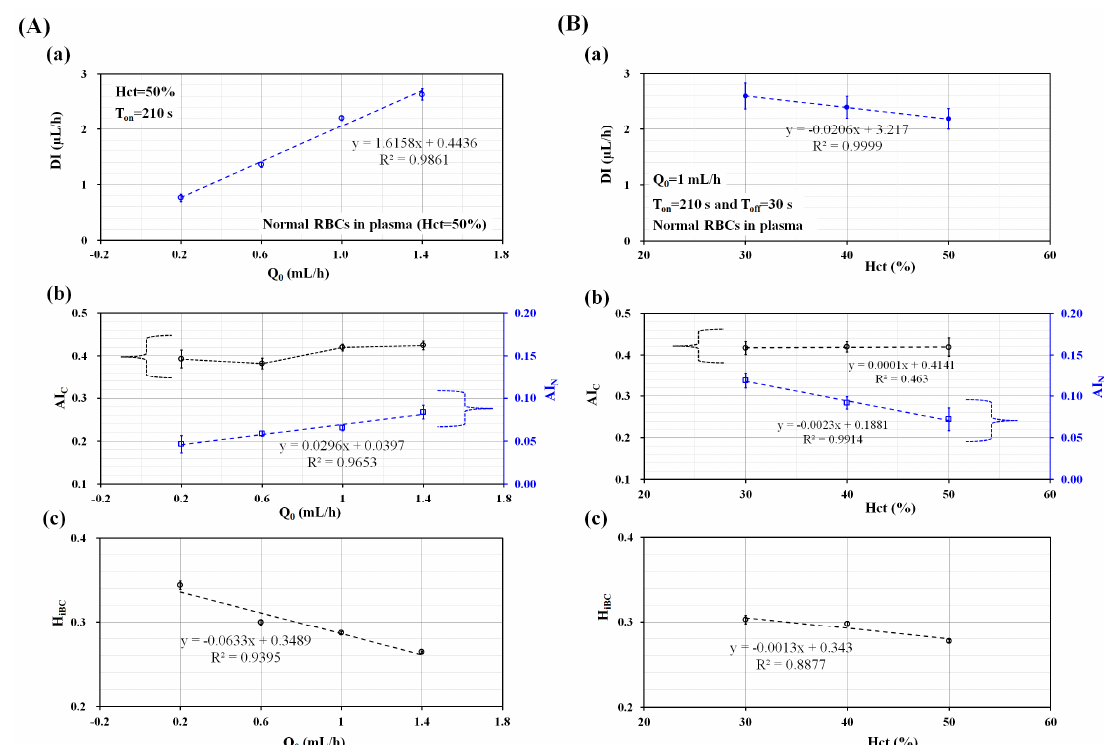
Figure 3. Quantitative evaluation of the effect of hematocrit (Hct) and amplitude of blood flow-rate (Q 0 ) on biophysical properties. The hematocrit of blood was prepared by adding normal RBCs into autologous plasma. A syringe pump supplied the blood into a microfluidic device at a periodic on–off profile (i.e., Q 0 = 1 mL/h, T on = 210 s, and T = 240 s). ( A ) The effect of the amplitude of blood flow-rate (Q 0 ) on variations of biophysical properties. ( a ) Variations of DI with respect to Q 0 = 0.2 mL/h, 0.6 mL/h, 1 mL/h, and 1.4 mL/h. ( b ) Variations of AI C and AI N with respect to Q 0 . ( c ) Variations of H iBC with respect to Q 0 . ( B ) The effect of hematocrit on variations of the biophysical properties. ( a ) Variations of DI with respect to Hct = 30%, 40%, and 50%. ( b ) Variations of RBC aggregation indices (AI C , and AI N ) with respect to Hct. ( c ) Variations of H iBC with respect to Hct.